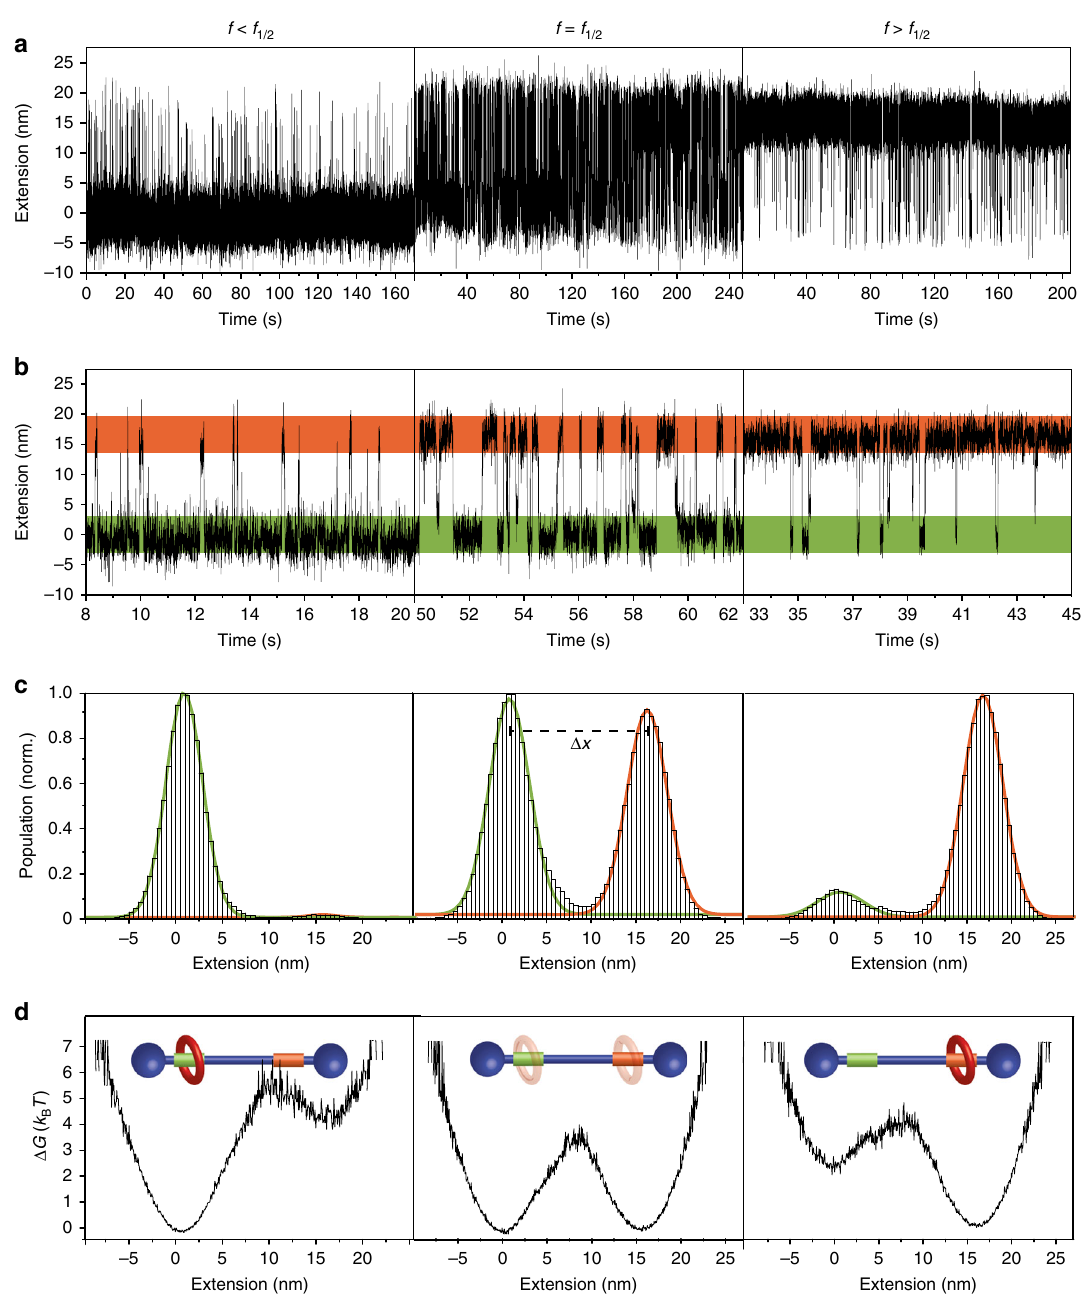
Fig. 3 Shuttling dynamics, positional control and energy pro fi les. a Extension vs. time data for single molecular shuttles at different constant forces. b Zoom-in on the data presented in a at arbitrary time intervals, showing residence and transition times. An average of 400 shuttling events were recorded for each molecular shuttle ( N = 24). c Extension histograms, fi tted with two Gaussian curves (orange and green lines) affording a shuttling distance of Δ x ~ 15 nm. d Energy pro fi les at each force, obtained directly from the relative populations depicted in ( c ). At force < f 1/2 (8.1 pN, left column), the macrocycle occupies preferentially the fum station (green). At force ~ f 1/2 (8.5 pN, middle column), both stations present similar occupancies . At force > f 1/2 (9.6 pN, right column), the macrocycle occupies preferentially the succ station